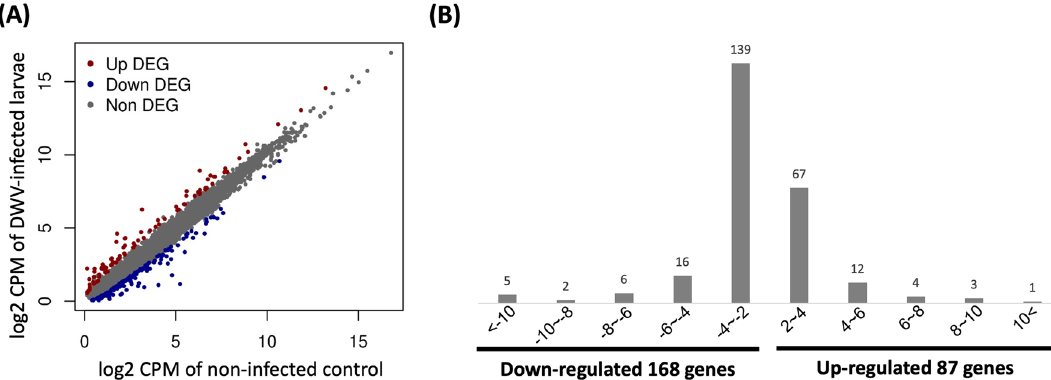
Figure 3. Overview of the fold change (log2 ratio ≥ 1) distribution of differentially expressed genes (DEGs). (A) Expression levels of the contigs in noninfected and DWV-infected larvae. (B) Analysis of DEGs identified from noninfected and DWV-infected samples. Downregulated genes are shown on the left side, and upregulated genes are shown on the right side. The expressed contigs with fold change ≥ 2 or ≤ -2 are listed, and the contig numbers with corresponding fold change are shown above each bar.